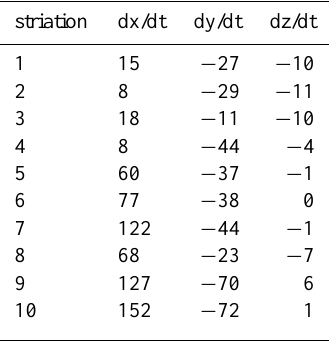
Table 1. Mean projection velocities (m/s) in the x, y and z directions of the striations in Fig.